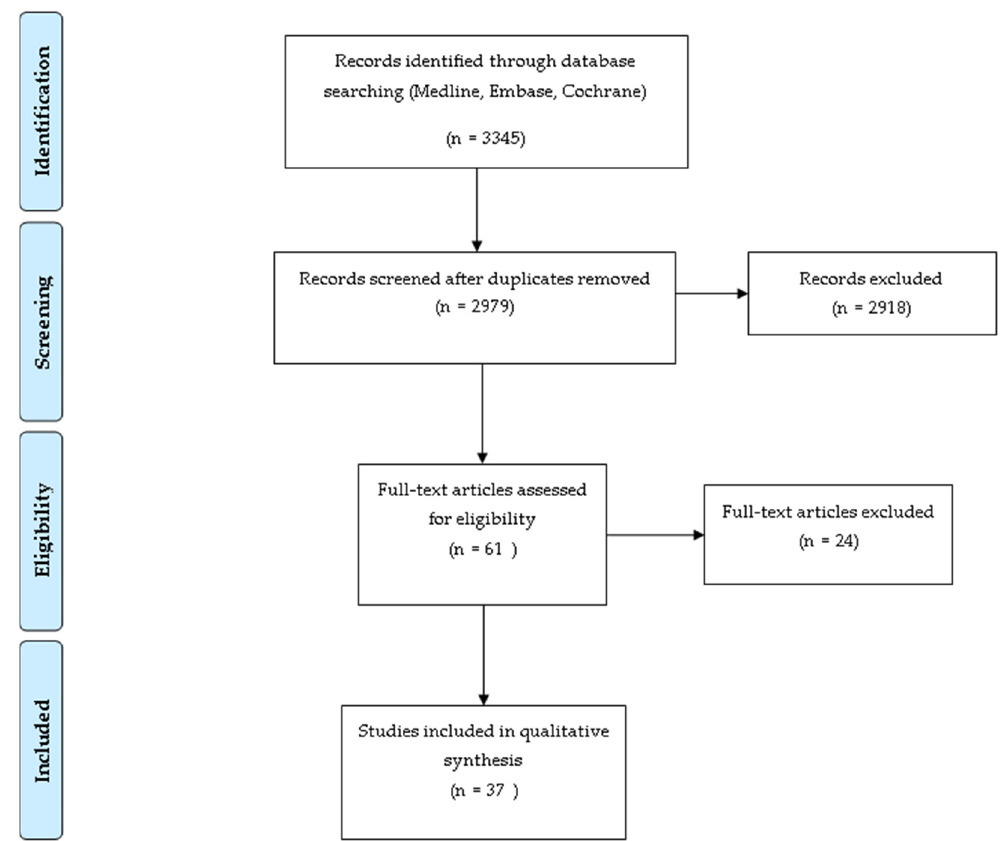
Figure 1. Preferred Reporting Items for Systematic reviews and Meta-Analyses (PRISMA) flow diagram for identification of relevant included and excluded studies .